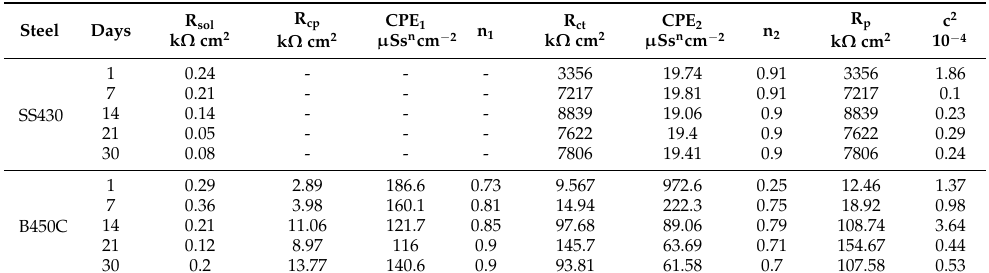
Table 11. Fitting parameters obtained from the EIS measurements for SS430 and carbon steel B450C exposed to supersulfated SS1 up to 30 days.